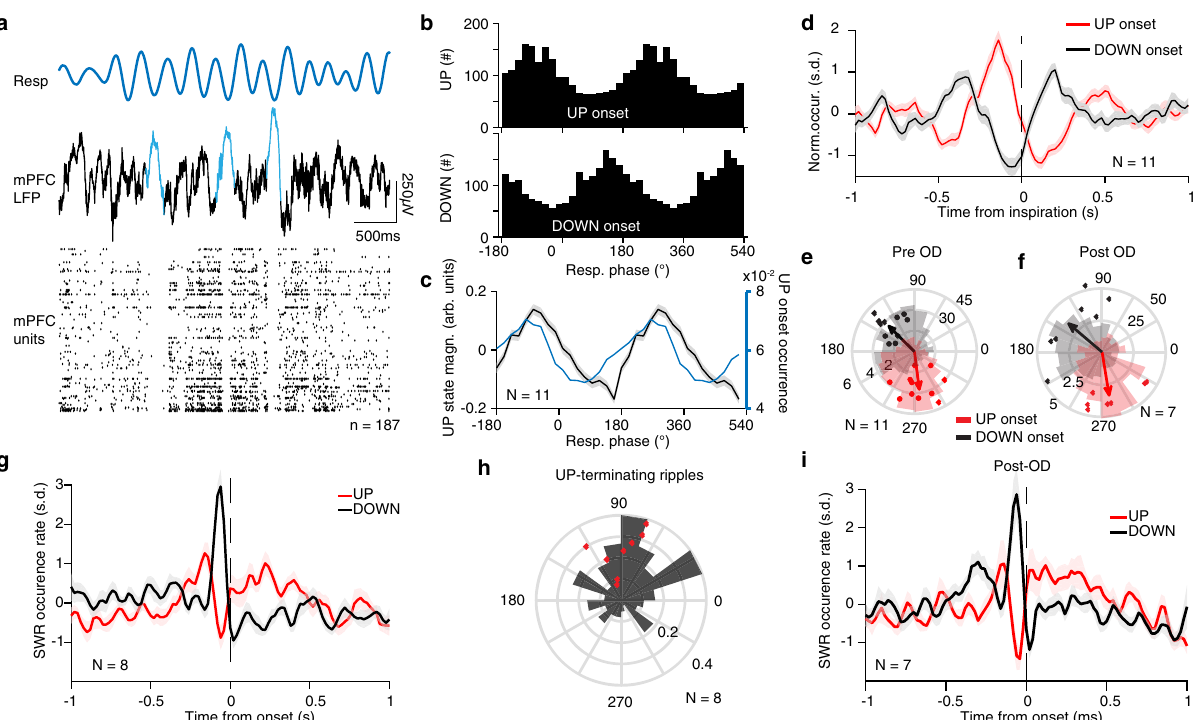
Fig. 7 Breathing modulates cortical UP/DOWN state transition. a Example traces of respiration signal (top), mPFC LFP (middle trace), and spike trains of 187 simultaneously recorded mPFC units during sleep. Three typical delta waves and the corresponding DOWN states of the neuronal population are marked with blue. b Example distributions of the breathing phase of UP (top) and DOWN (bottom) state onsets. c Normalized power (black) and occurrence rate (blue) for prefrontal UP states ( N = 11 freely-behaving and head- fi xed mice). d Cross-correlation of UP and DOWN state onsets with respect to inspiration. e , f Distribution of preferred breathing phase and phase modulation magnitude (logZ) of UP and DOWN states before ( e ) and after ( f ) OD. (pre: N = 11 mice, post: N = 7 mice). Histograms are for one example session (scale is a count of UP/DOWN states). g Normalized occurrence rate of SWR as a function of time from UP or DOWN state onset ( N = 8 mice). h Example (black) and distribution of preferred breathing phase of SWR occurrence, for SWRs that are terminating a UP state (red dots, N = 8 mice). i Normalized occurrence rate of SWR as a function of time from UP or DOWN state onset after OD ( N = 7 mice). Note that the observed pattern is identical to the pre-OD shown in ( g ). For box plots, the middle, bottom, and top lines correspond to the median, bottom, and top quartile, and whiskers to lower and upper extremes minus bottom quartile and top quartile, respectively. s.d. standard deviations, arb. units arbitrary units, OD olfactory deafferentation. Shaded areas, mean ± SEM. Star indicates signi fi cance level (* P <